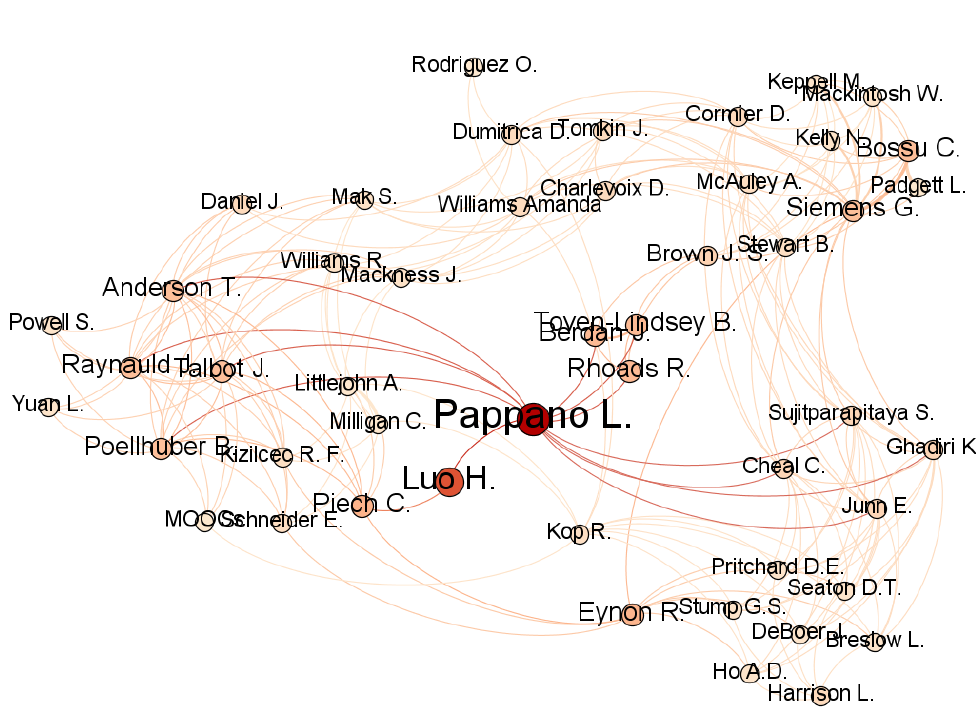
Figure 4 . Phase 2 citation